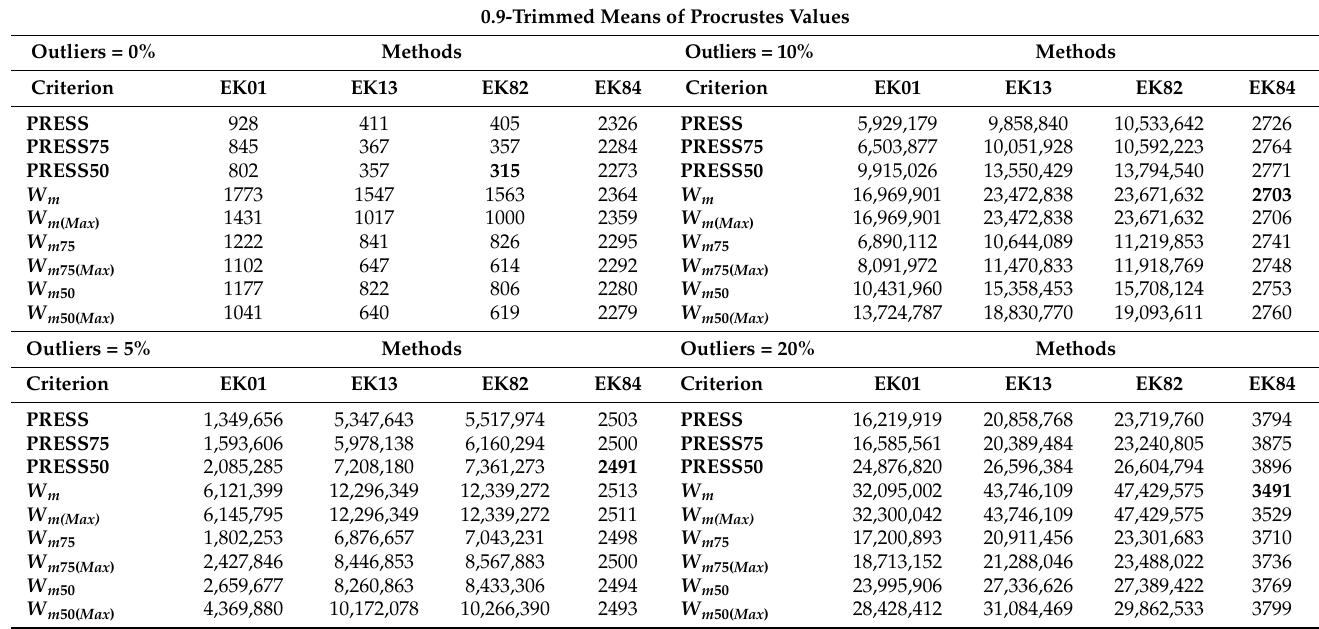
Table 1. The 0.9-trimmed means of Procrustes values in the simulation